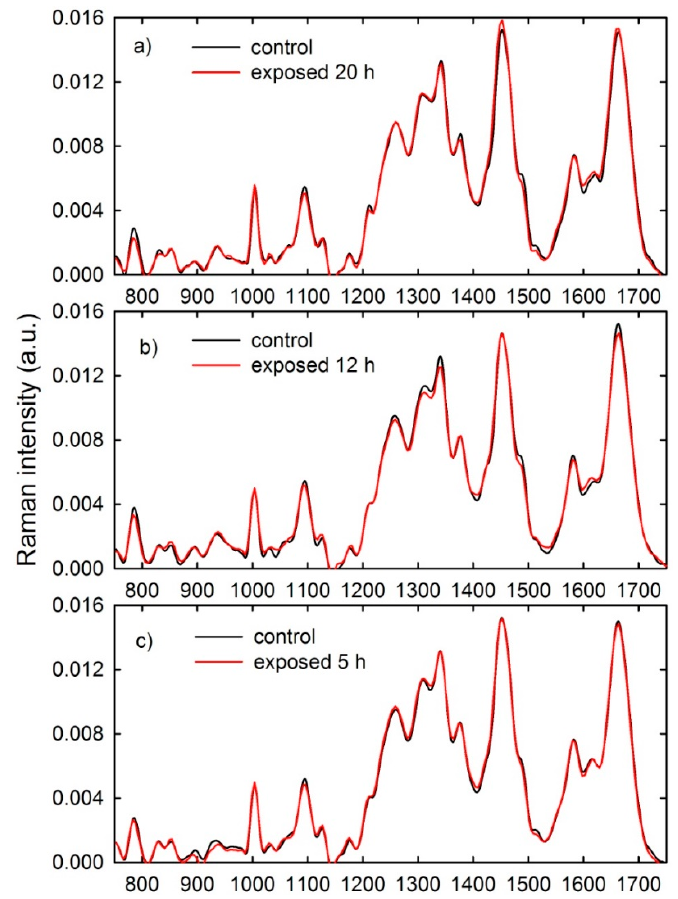
Figure 2. Average Raman spectra of control (black line) and exposed (red line) PBLM cells. The PBLM cells were exposed for 20 ( a ), 12 ( b ) and 5 ( d ) hours.